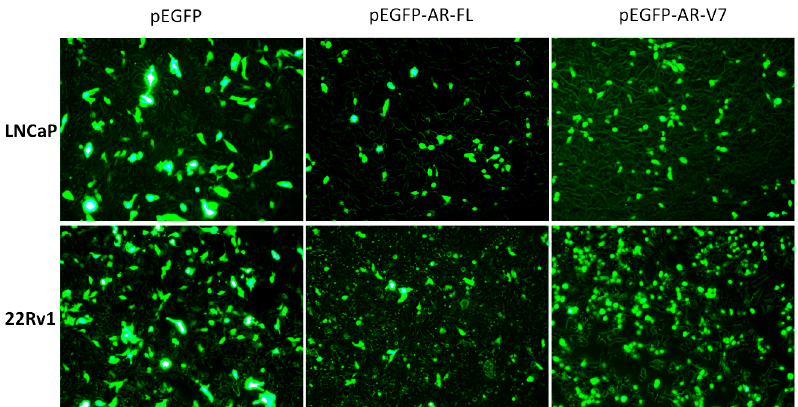
Figure 1. Fluorescence microscopy of LNCaP and 22Rv1 cells transfected with empty plasmid vector (pEGFP), plasmid encoding full-length androgen receptor (pEGFP-AR-FL), or plasmid encoding androgen receptor splice variant-7 (pEGFP-AR-V7). The signals were observed under a fluorescence microscope at 20× magnification. EGFP = enhanced green fluorescent protein.